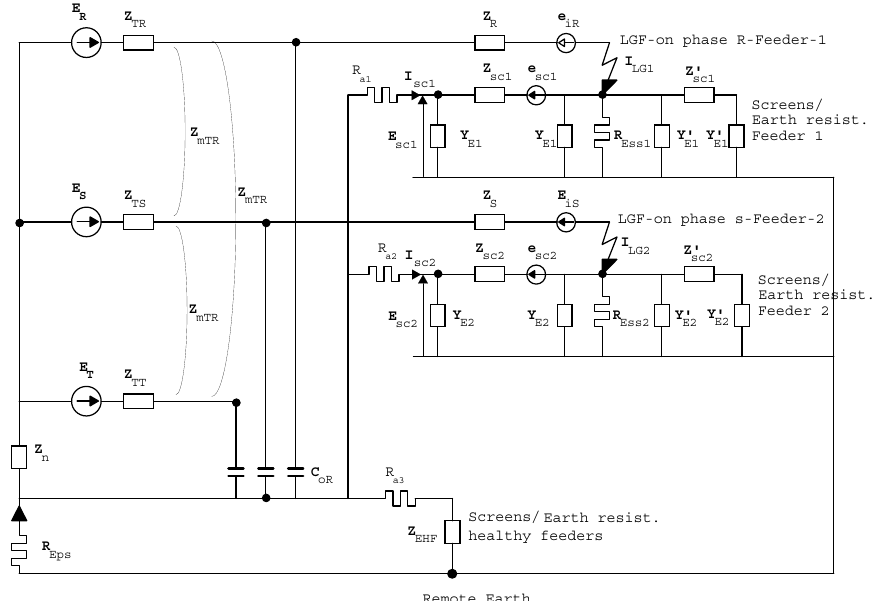
Figure 4. Equivalent circuit of a MV distribution network in case of a CCF occurring in two different cable lines.